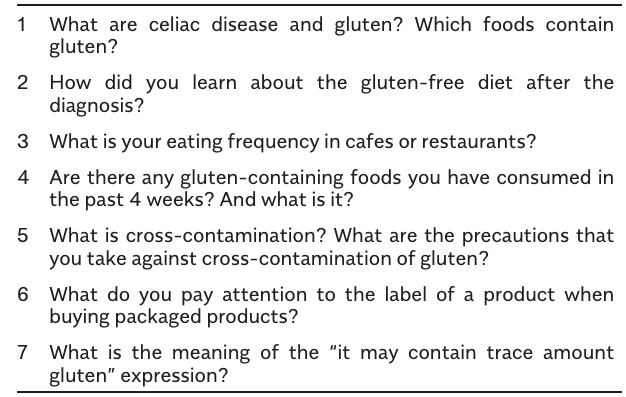
Table 1. Questions for the Evaluation of Compliance to Gluten-free